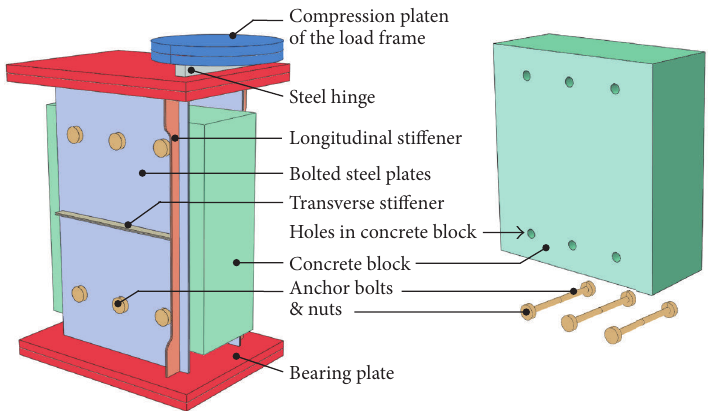
Figure 2: Instance assembly of the local buckling test modeling.